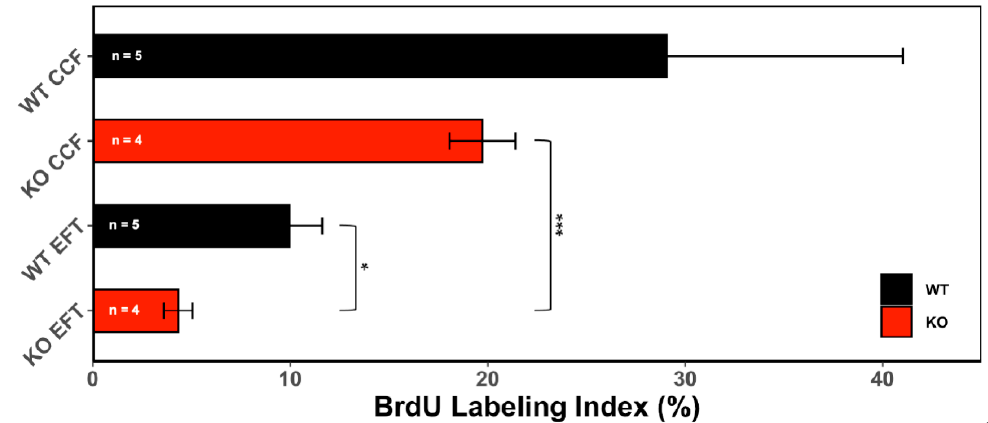
Figure 2. CCF mediate abnormal proliferation activity of hepatocytes. Shown data represent the proliferative activity (measured by BrdU-LI, one-week measurement via an osmotic mini pump) of CCF and extrafocal tissue (EFT) in wild type (WT) and ChREBP-knockout mice (KO). Data are depicted as mean ± S.E.M.; * p < 0.05; *** p < 0.001.